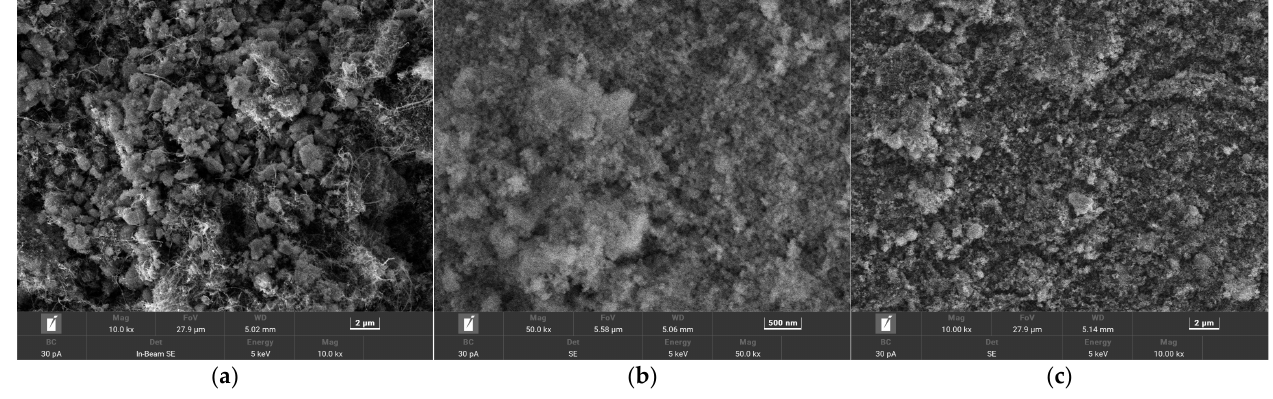
Figure 1. SEM images of composite adsorbent. ( a ) SEM images of MOF-801/CNT. ( b ) SEM images of MOF-801/G. ( c ) SEM images of MOF-801/CB. The activated MOF-801/G, MOF-801/CB, and MOF-801/CNT were characterized by